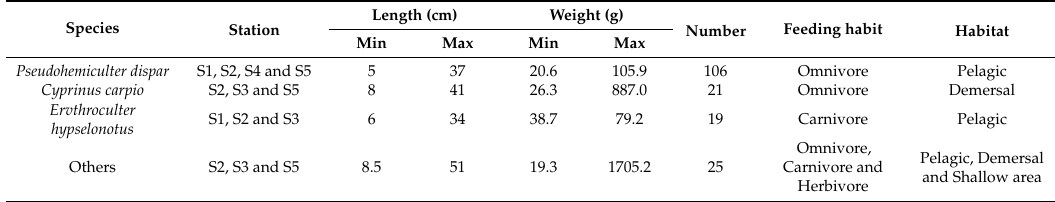
Length (cm) Weight (g)